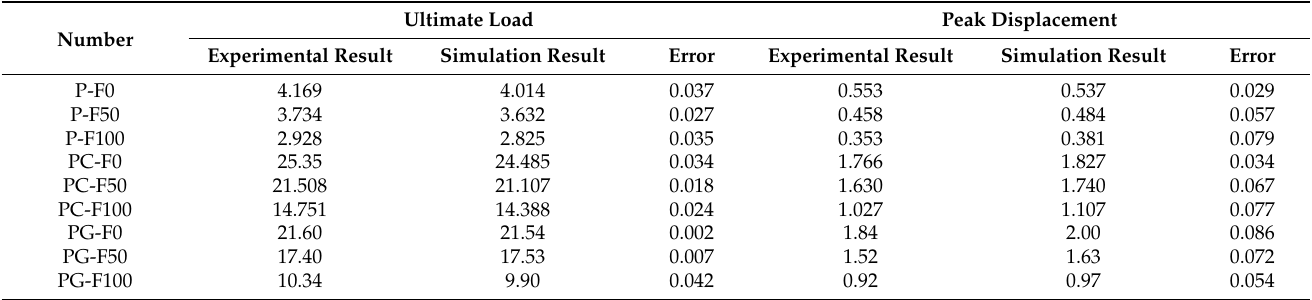
Table 8. Comparison of experimental results and numerical results of flexural